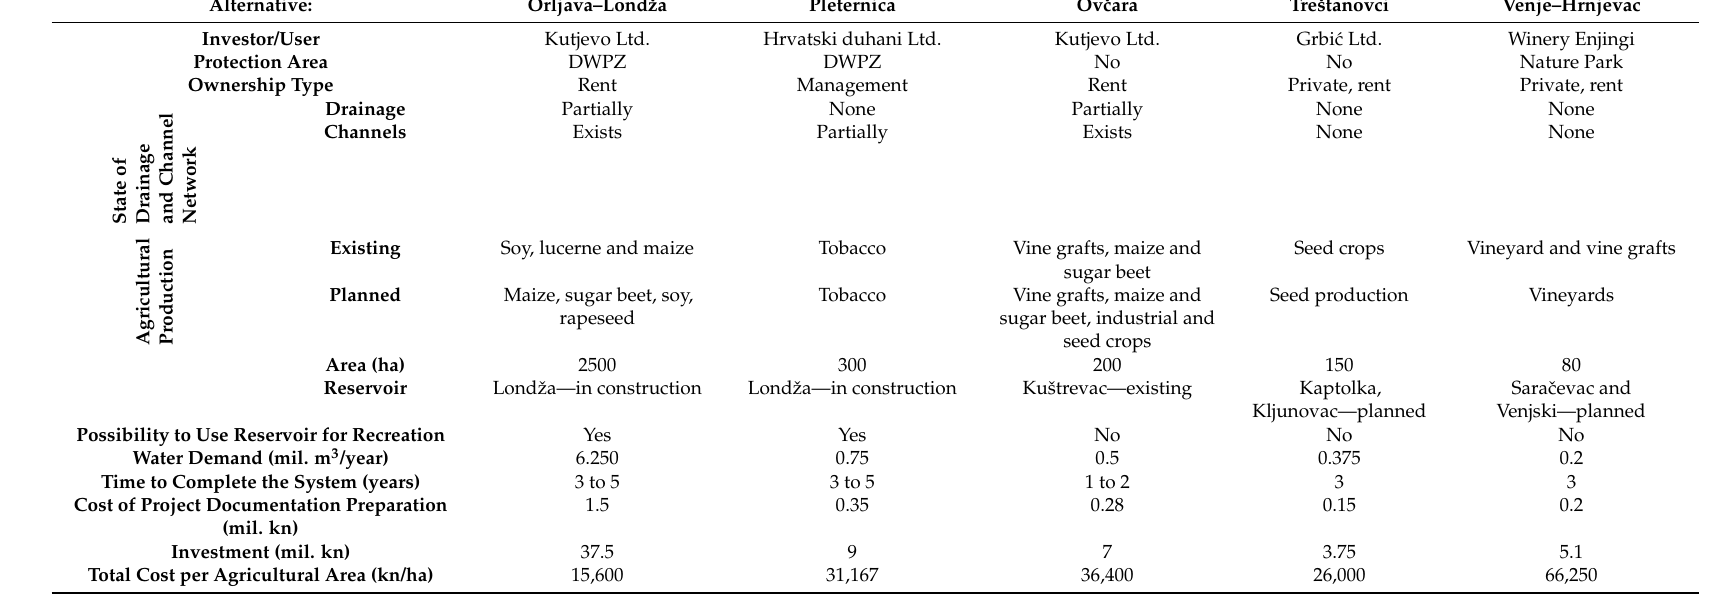
Table 1. Characteristics of all areas (alternatives)